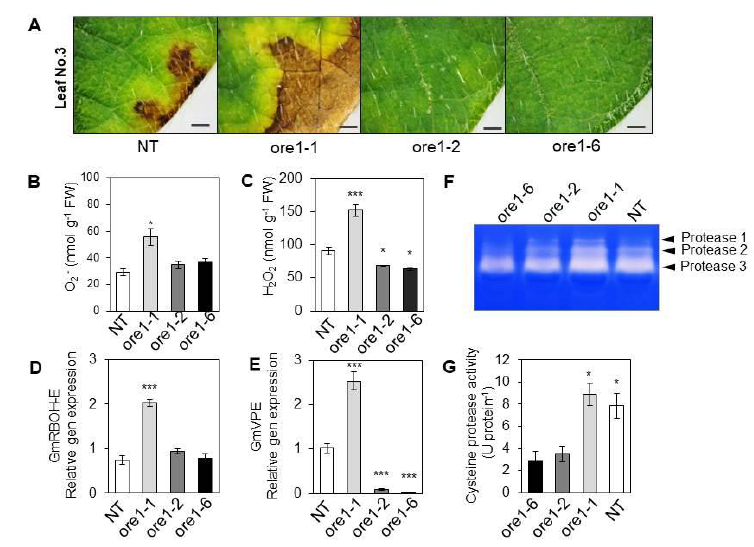
Figure 4. Phenotypic characterization of programmed cell death (PCD) symptoms and accumulation of reactive oxygen species (ROS) in leaves of transgenic plants and wild-type (NT). ( A ) Leaf No.3 fully experiences programmed cell death (PCD) from 6-week-old plants. Leaf cell death is retarded in the leaf edge in the ore1-1 line rather than ore1 -2 and ore1 -6 transgenic lines. This symptom was developed in rosette leaf are numbered from 1 (older leaf) to 3–4 (middle leaf) are shown as well. The photo was taken under microscopy Stemi 508 (Carl Zeiss, Germany) with 40 × , bar 2 mm. ROS levels were measured by ( B ) O 2 − and ( C ) Hydrogen peroxide (H 2 O 2 ) in detected leaves. ( D ) Transcript level of respiratory burst oxidase homologs E (RBOH-E) is a producer of ROS production. ( F ) GmRBOH-E expression was detected in wild-type (NT) and soybean transgenic leaves. ( E ) Transcript levels of a vacuolar-processing enzyme (VPE) is a related gene associated with cell death in the detected leaf No.3. qPCR was used to quantify the enrichment of the ROS-induced cell death. ( F ) Cysteine protease activity was detached by gel-staining of each transgenic line compared to the wild-type. ( G ) Cysteine protease activity in the detached leaves. Data are means ± SE of three independent biological replicates ( n = 3). Asterisks indicate significant differences from wild-type (NT) and transgenic plants according to Tukey ’s t -test; ∗ p < 0.05, ∗∗ p < 0.01, ∗∗∗ p < 0.001.